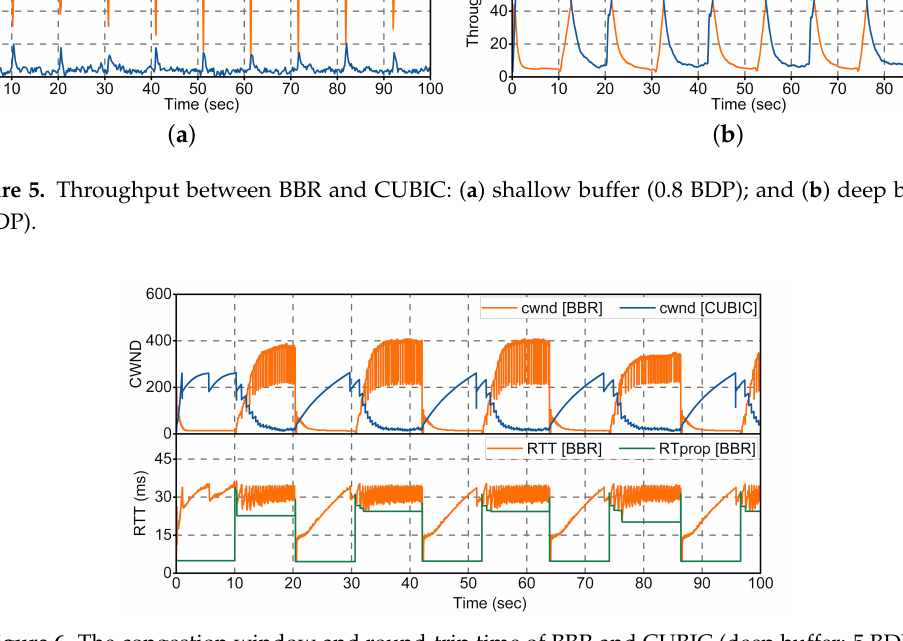
Figure 6. The congestion window and round-trip time of BBR and CUBIC (deep buffer: 5